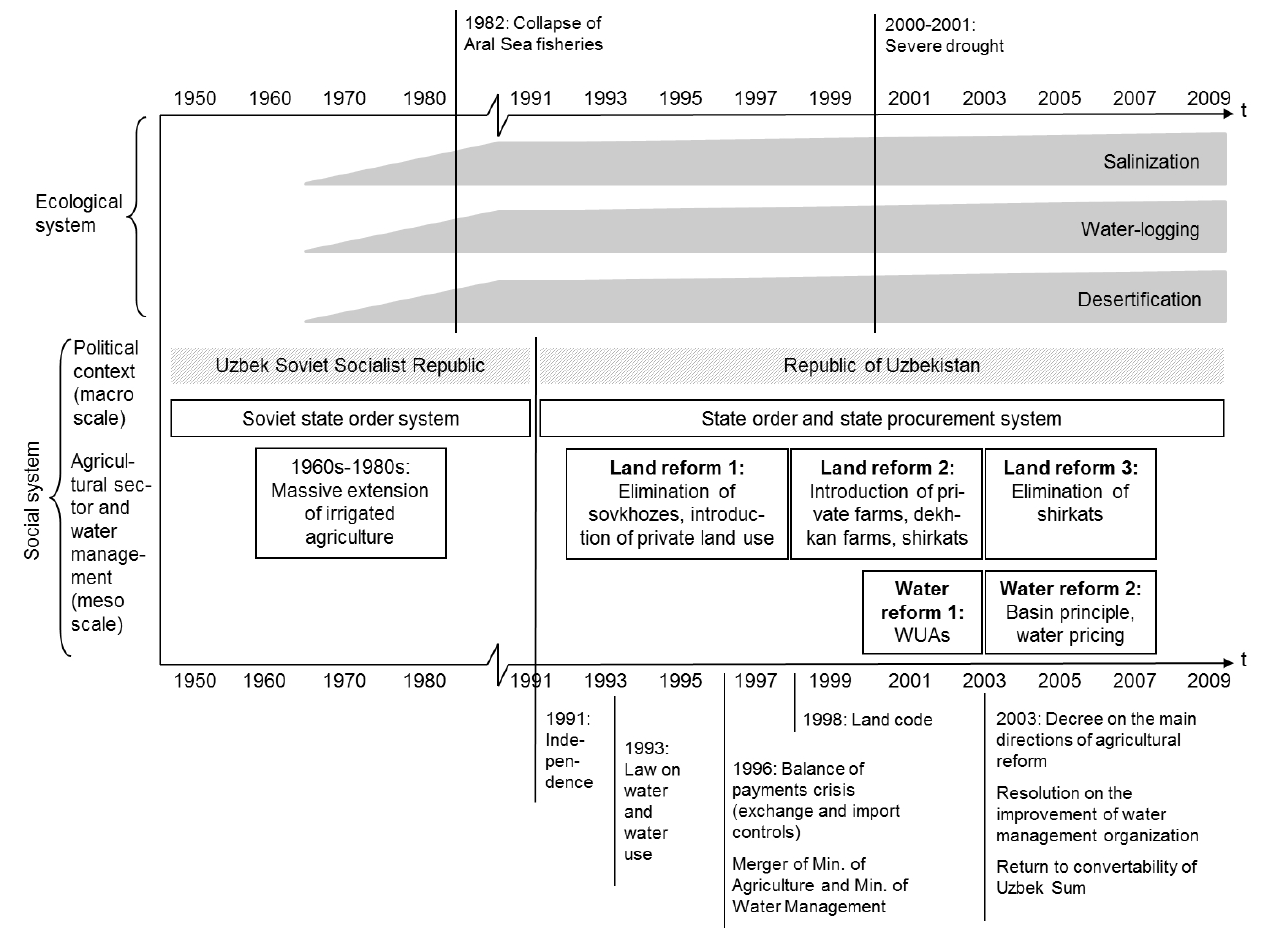
Fig. 3 . Timeline of major events in the SES in the Uzbek part of the Amudarya River